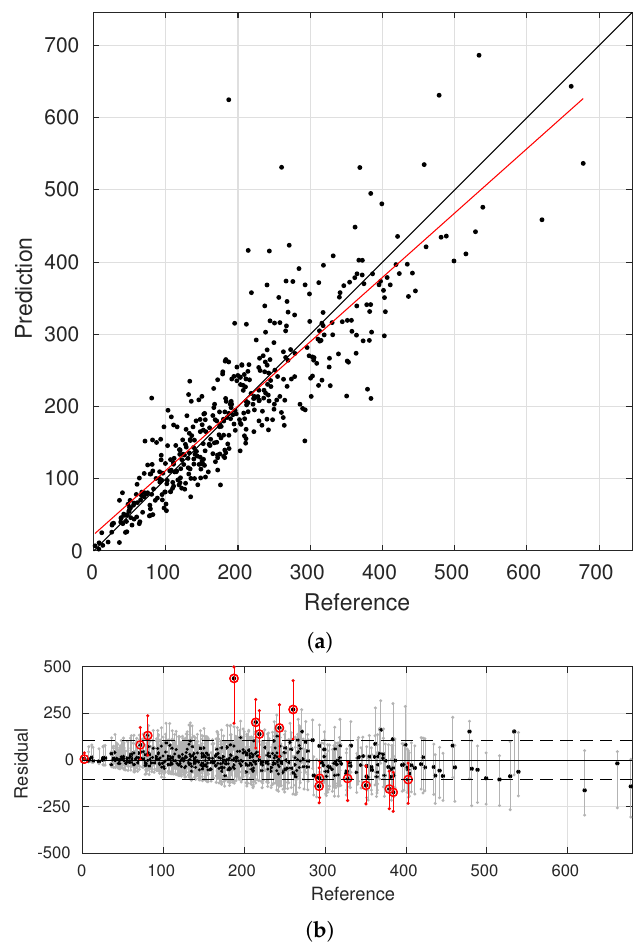
Figure 5. Panel 5a : Corrected predictions of volume [m 3 /ha] versus the reference set (truth) volume [m 3 /ha], 1:1 line in black, linear fit between predictions and reference values in red. Panel 5b : The residuals [m 3 /ha] of the corrected predictions with black dots, 95% probability intervals with the truth within the interval in gray, the truth outside the interval in red, and the range of 95% probability interval of the predicted values ( ∼± 1.96 · root mean square error) with dashed